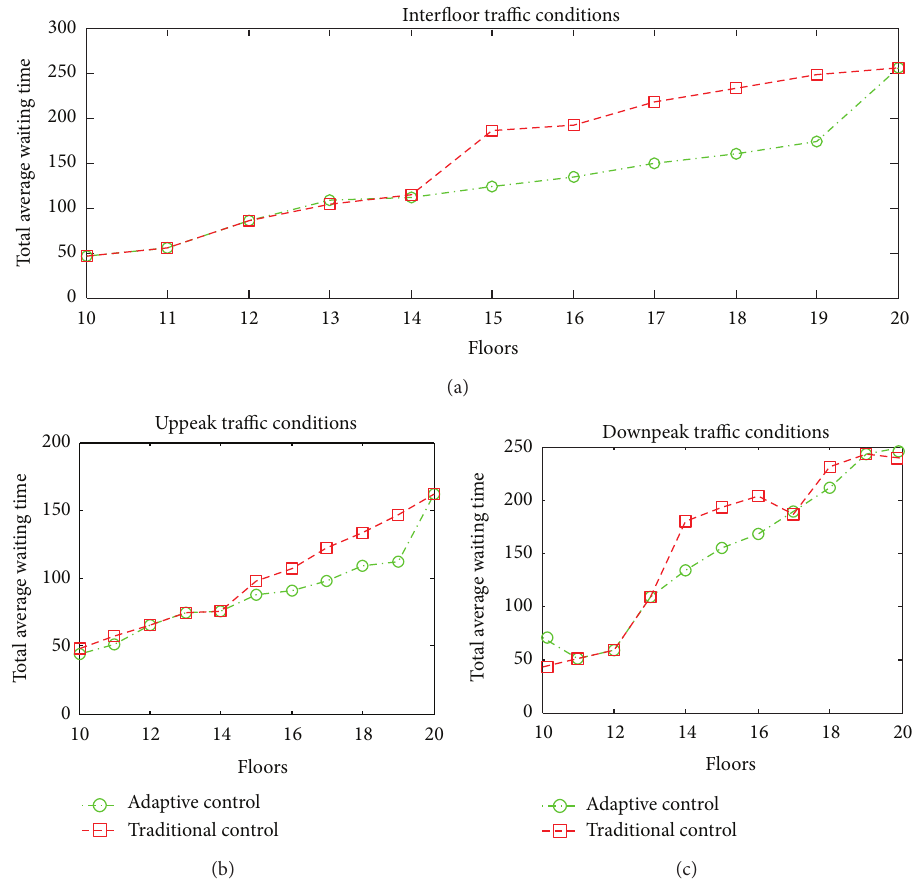
Figure 11: Comparative results for classical methods and the proposed approach.